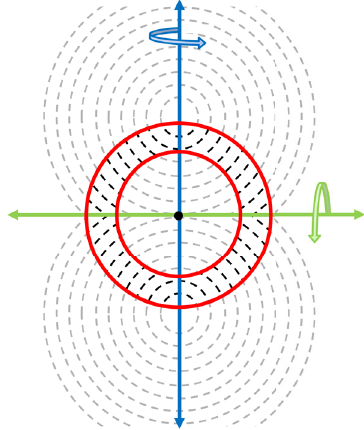
FIG. 5. Double spirals are signatures of FCDs. Layers of concentric circles (dashed lines), representative of cholesteric layers, collide on a focal line (green). In red, we depict the surfaces of the shell confining the cholesteric, separating physical areas of the circular sections (black dashed lines) from virtual areas (gray dashed lines). If we rotate the two-dimensional texture around the vertical axis (blue), we get a texture between two red spheres with a focal plane dividing the top and bottom concentric CLC spheres. Topology, however, creates two charge þ 1 nematic defects along the rotation axis. Though a þ 1 disclination in a uniaxial nematic can “ escape into the third dimension ” [46], the biaxial-like cholesteric texture cannot [27]. As a result, the nematic disclinations become pitch defects, located along the rotation axis. Alternatively, if we rotate the two-dimensional texture around the horizontal axis (green), we generate a toroidal focal conic [45], with one focal line connecting the centers of the concentric CLC circles and another focal line along the axis of rotation. Pitch defects, at the center of double spirals, are located along the green axis of rotation. The director configuration within the shell is similar for either of these rotation axes. The structure of the FCDs becomes more complex as the number of double- spiral domains